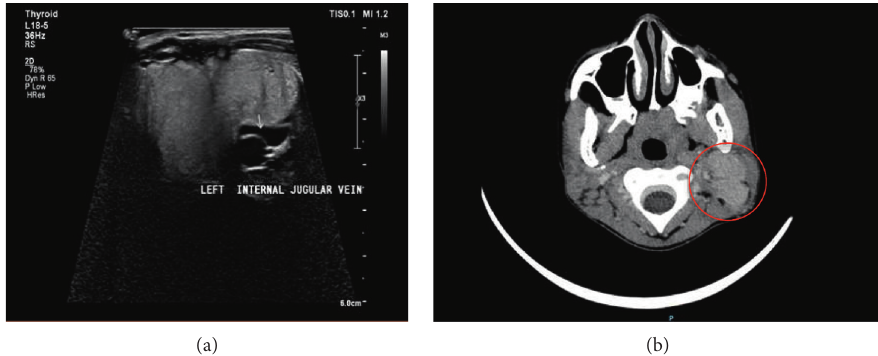
Figure 1: (a) Neck ultrasound shows enlarged left cervical lymph node compressing on the left internal jugular vein; (b) CT scan shows mattered left cervical lymphadenopathy ( ).